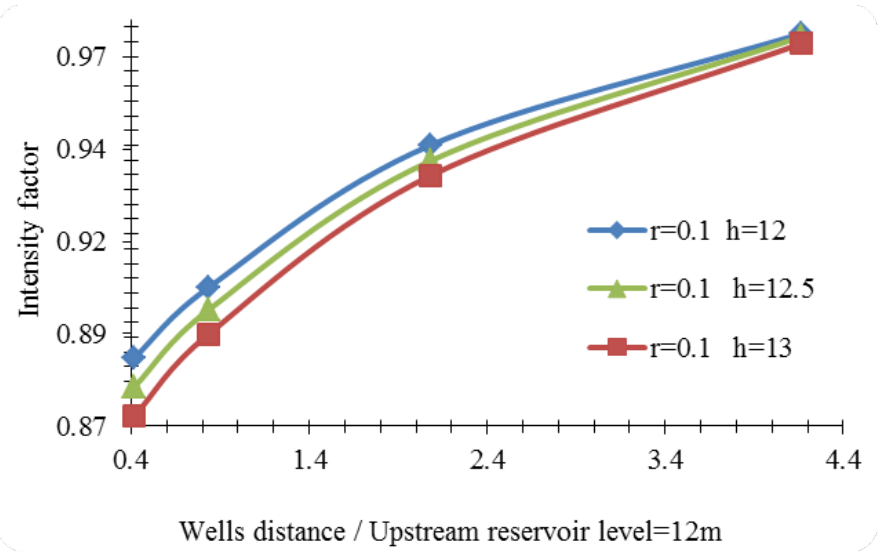
Fig. 11. Effect of upstream reservoir level on uplift pressure for a well with 0.1 m in